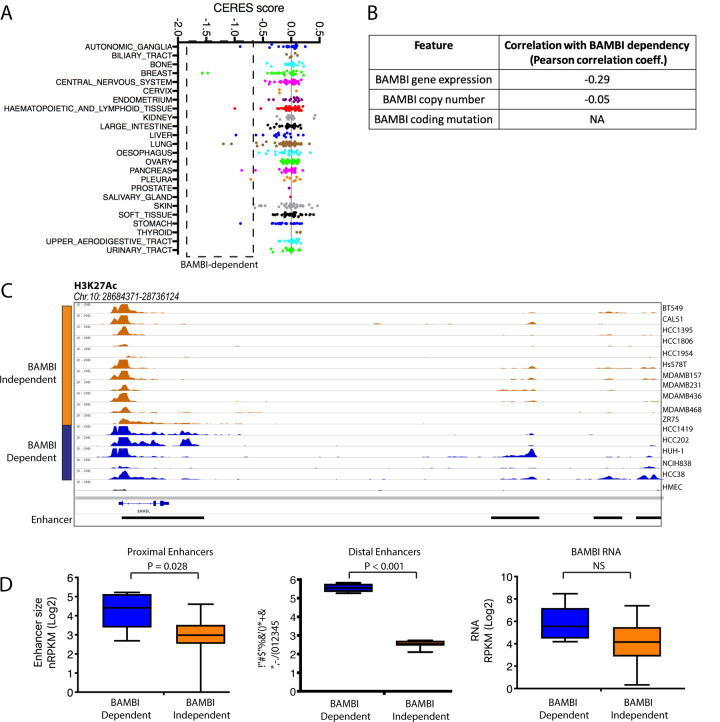
Fine-resolution analysis of BAMBI superenhancer landscape.A) Project Achilles data representing BAMBI knock out in 342 cancer cell lines. Drop-out is represented by CERES score. Box denotes all cell lines that have significant growth dependencies on BAMBI. B) Correlation between BAMBI dependency and the indicated genomic features in Project Achilles data. C) H3K27Ac ChIP-Seq tracks for BAMBI-independent TNBC lines, HCC38, and BAMBI dependent non-TNBC cell lines identified in project Achilles. High-variance enhancer regions are denoted below tracks. D) Left panel shows boxplot of summed BAMBI-proximal variant enhancer peaks annotated in C). Middle panel shows boxplots of summed BAMBI-distal variant enhancer peaks. Right panel shows boxplot of BAMBI RNA expression for BAMBI knock out sensitive and insensitive cell lines. Box indicates median, 25th and 75th percentiles, whiskers indicate min and max. * indicates significant difference P<0.001 as determined by Mann-Whitney U test.